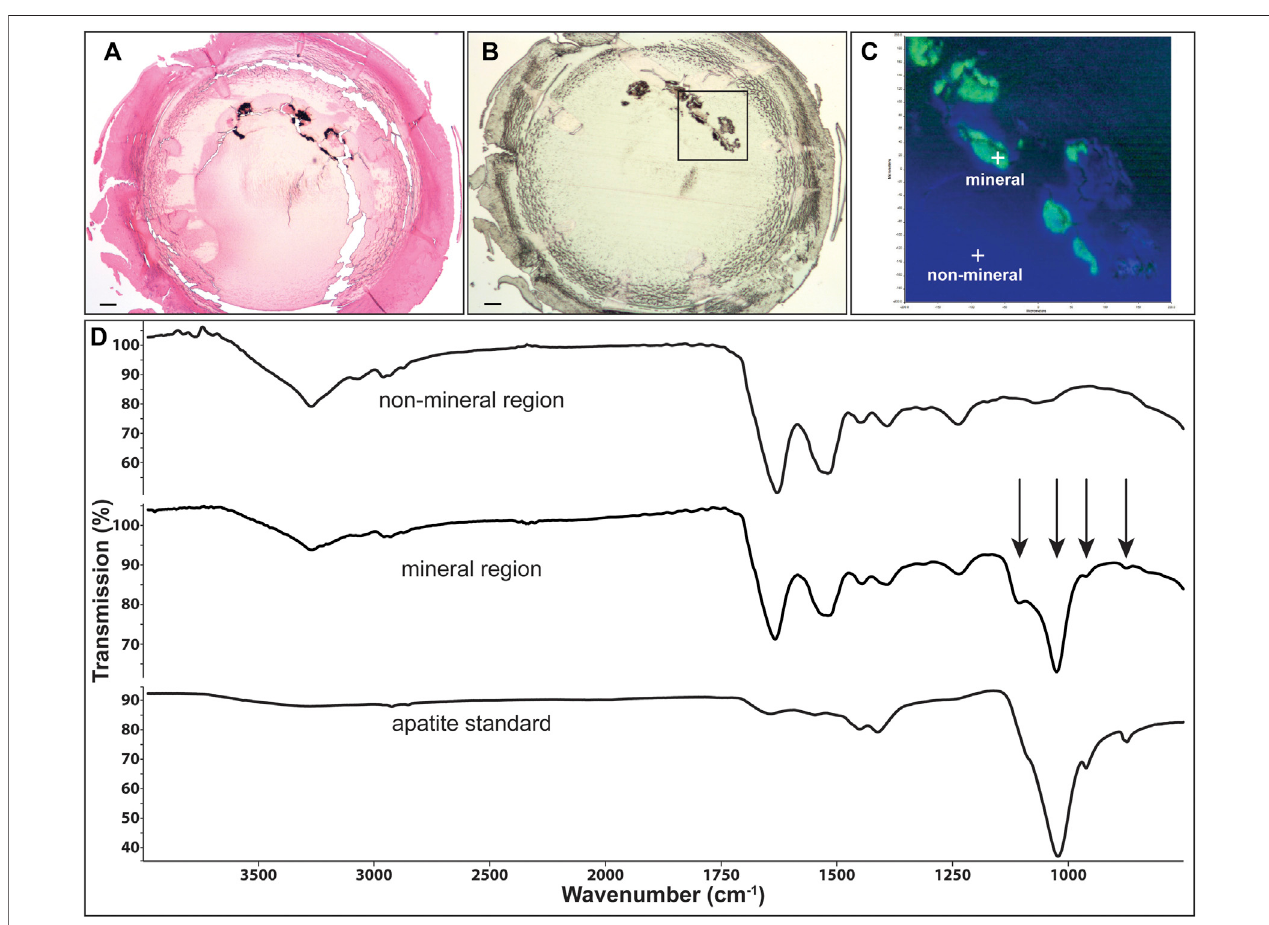
FIGURE 5 | Identi fi cation of mineral type in Cx46fs380 lenses. (A) Image showing Yasue staining of a section from the lens of the 171-day old homozygous Cx46fs380malemouseshownin Figure1 .Theblackstainedmaterialcorrespondstocalci fi cations. (B) Imageofanunstainedsectionofthesamelensonlowemissivity glassthatwasusedforinfraredimaging. (C) Imageshowstheinfraredsignalmapobtainedoftheboxedregionshownon (B) bycollecting65,746infraredspectrawitha pixel resolution of 1.56 μ m. Green areas are mineral regions and blue areas are protein regions. (D) Graphs show the spectra of a non-mineral region, a mineral region, and the apatite standard. Arrows point to features characteristic of apatite mineral in the lens. The scale bars in (A,B) represent 100 μ m.